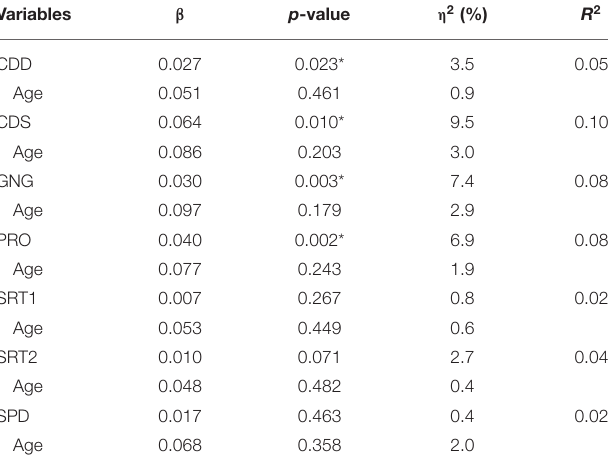
TABLE 2 | Results of comparison between the DANA Brief subtest mean throughput scores and MACE cognitive test scores in the linear mixed model (Equation 2).